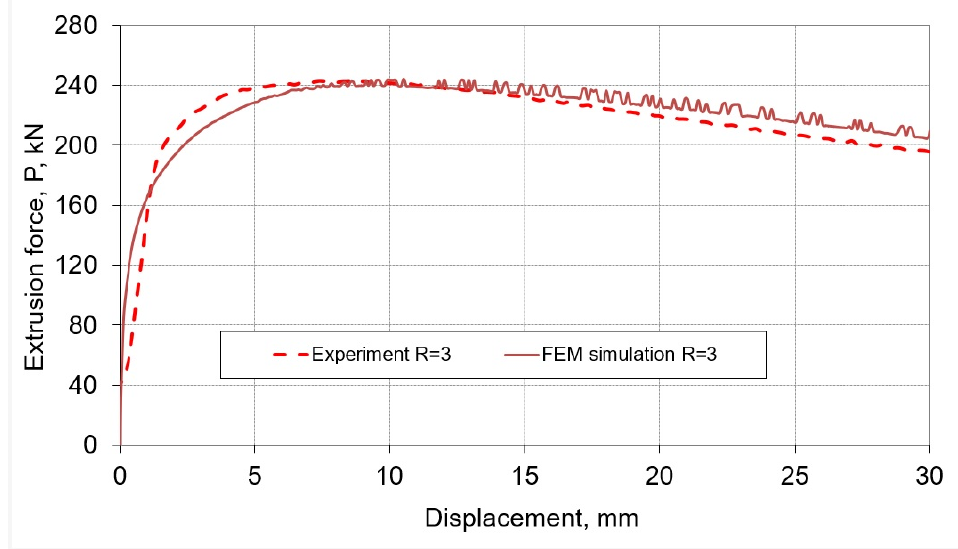
Figure 2. Experimental and numerical characteristics of the extrusion force—the displacement of the punch for the extrusion ratio R = 3. The numerical modeling of the concurrent extrusion process was performed using MSC MARC/Mentat software supporting the non-linear contact problems. The model built was an axially symmetrical two-dimensional one. Some examples of geometric models for FEM calculations with a 3.5 mm punch displacement for two different elongation ratios R = (3 and 11) are shown in Figure 3. It was assumed that the surfaces of punch one and container two were perfectly rigid, while extruded material three and die four were modeled as deformable